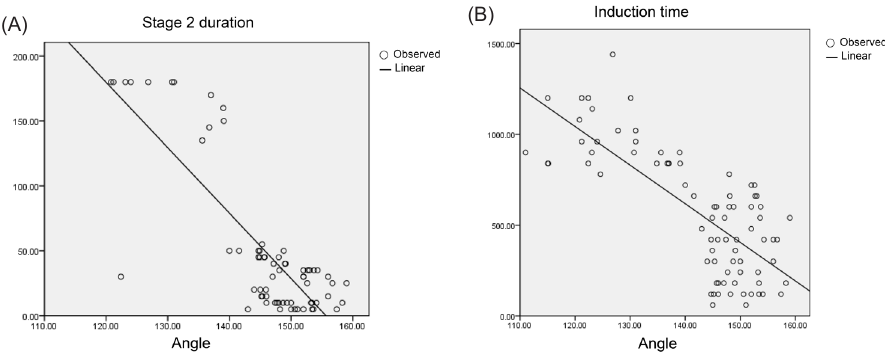
Figure 2. (A) Correlation between angle of progression and stage 2 duration. (B) Correlation between angle of progression and induction time.